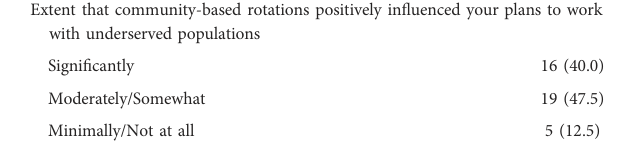
TABLE 1 Frequency and percent distributions of foreign-trained dentists ’ responses to items from an assessment of a CBDE program that occurred May of 2018 to April of 2019, N